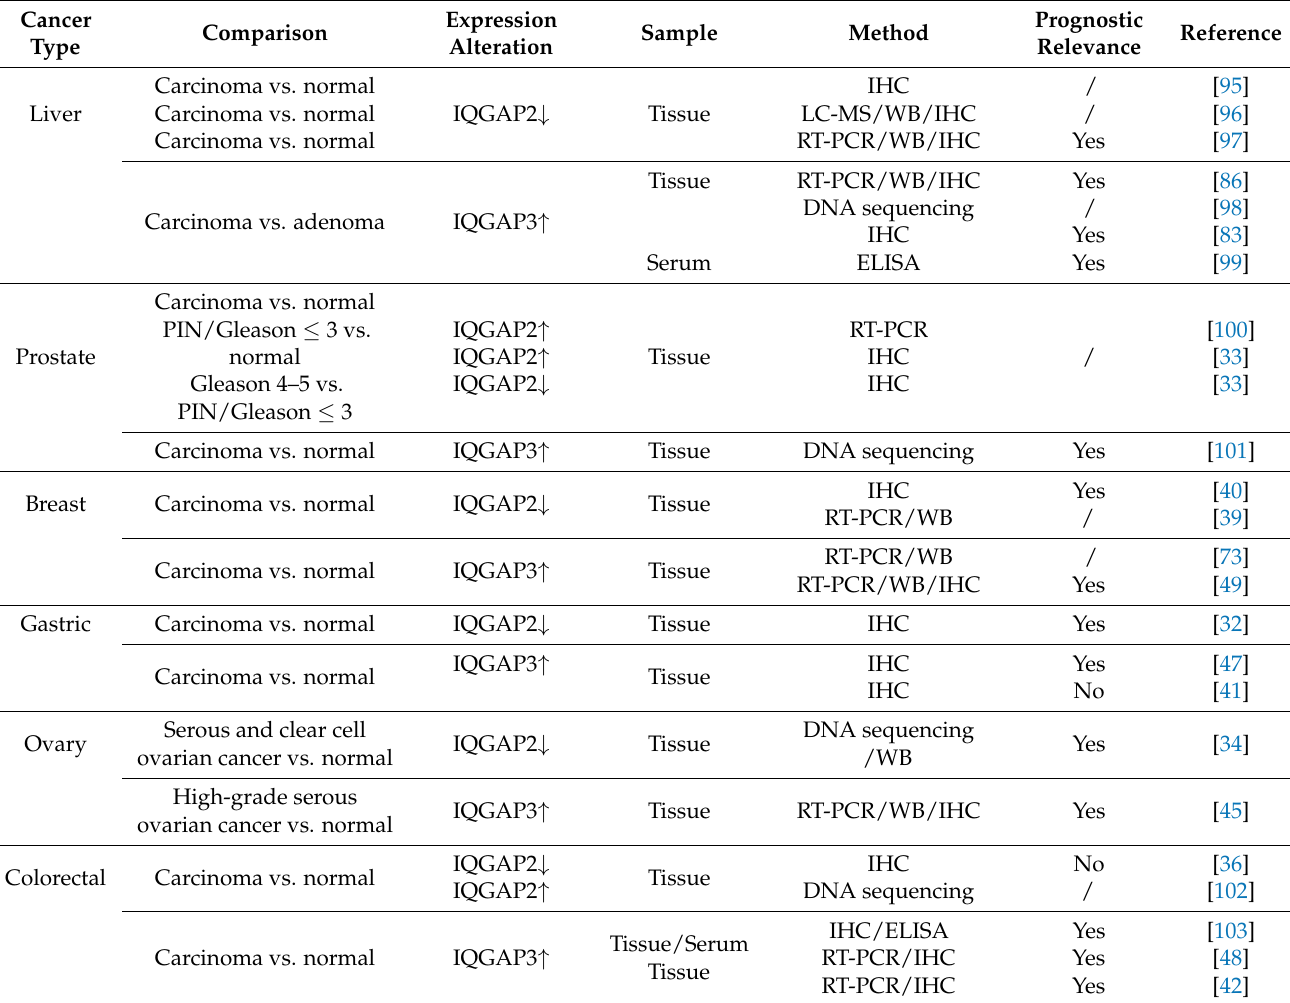
Table 2. Cancers with altered IQGAP2 and IQGAP3 expression. IHC: